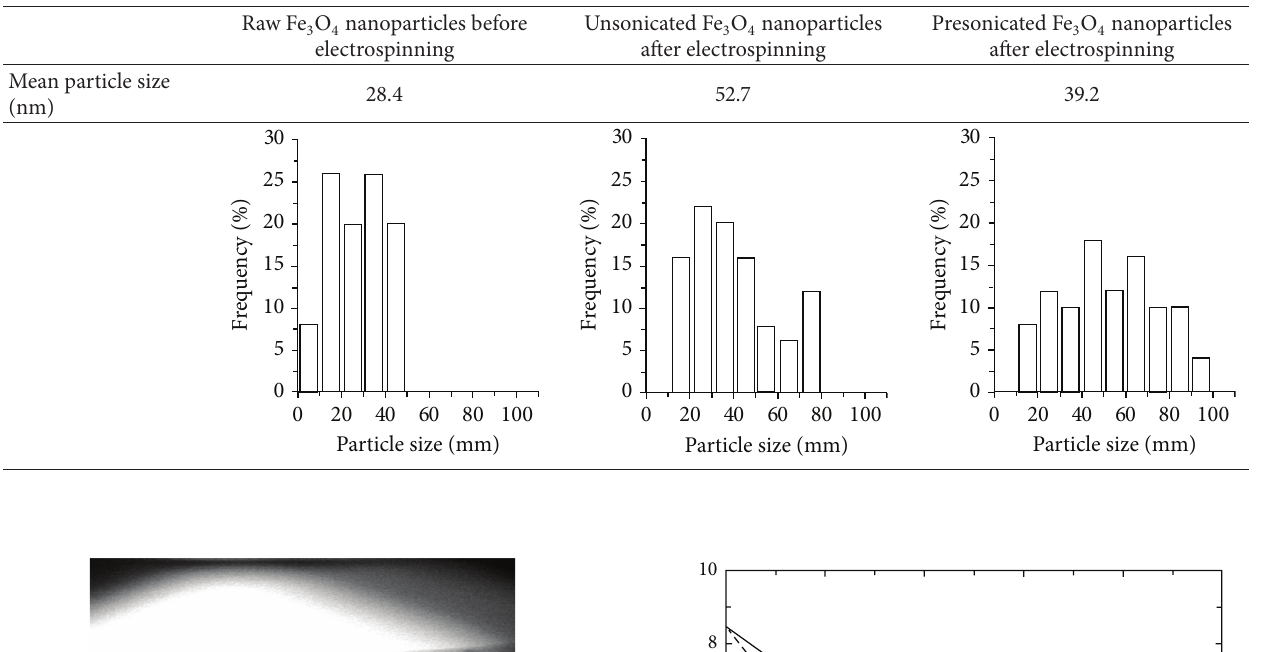
O nanoparticles before and after inclusion within electrospun fibres. 3 4